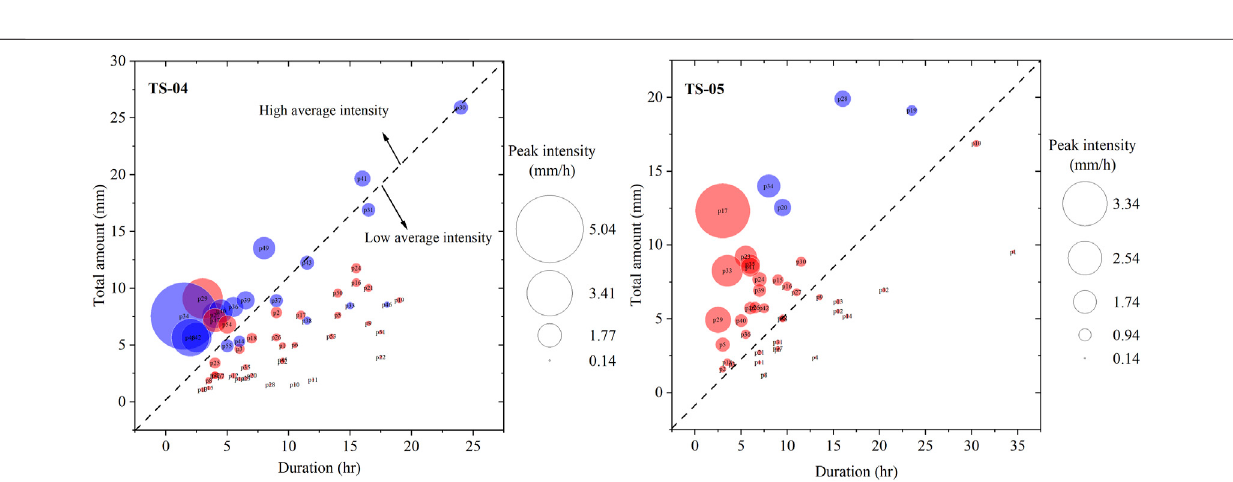
Frontiers in Earth Science |